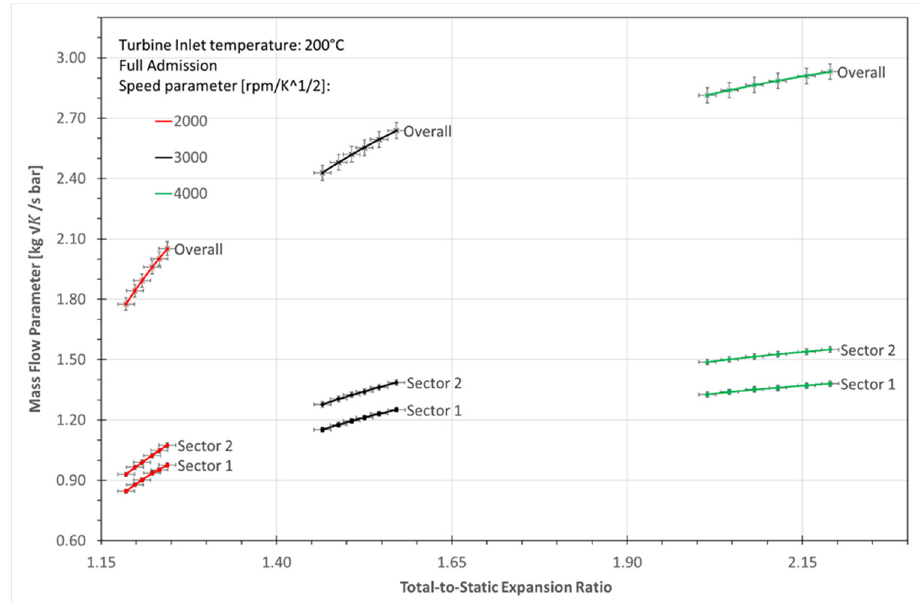
Figure 5. Comparison between MFP, MFP1, and MFP2 in full admission conditions.